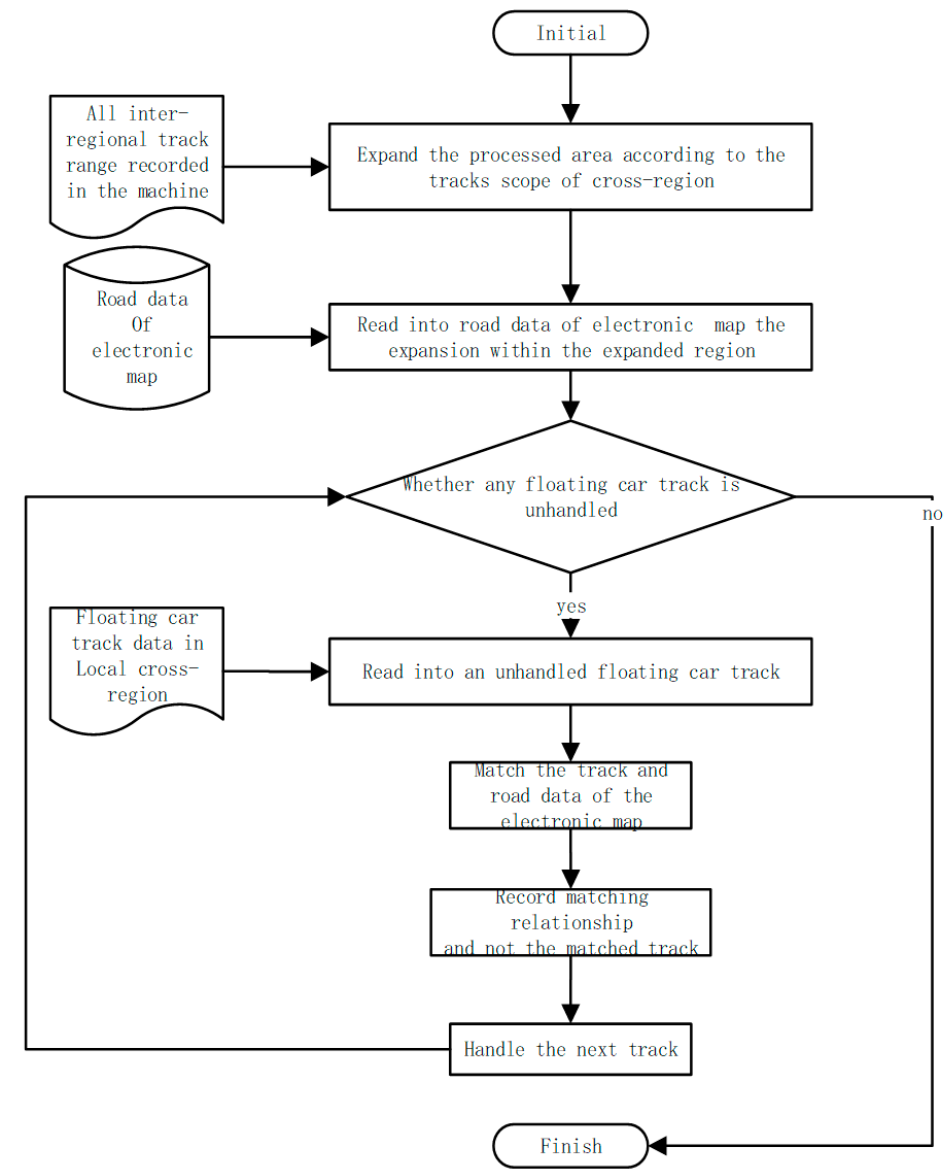
Figure 5. Second map algorithm flow.